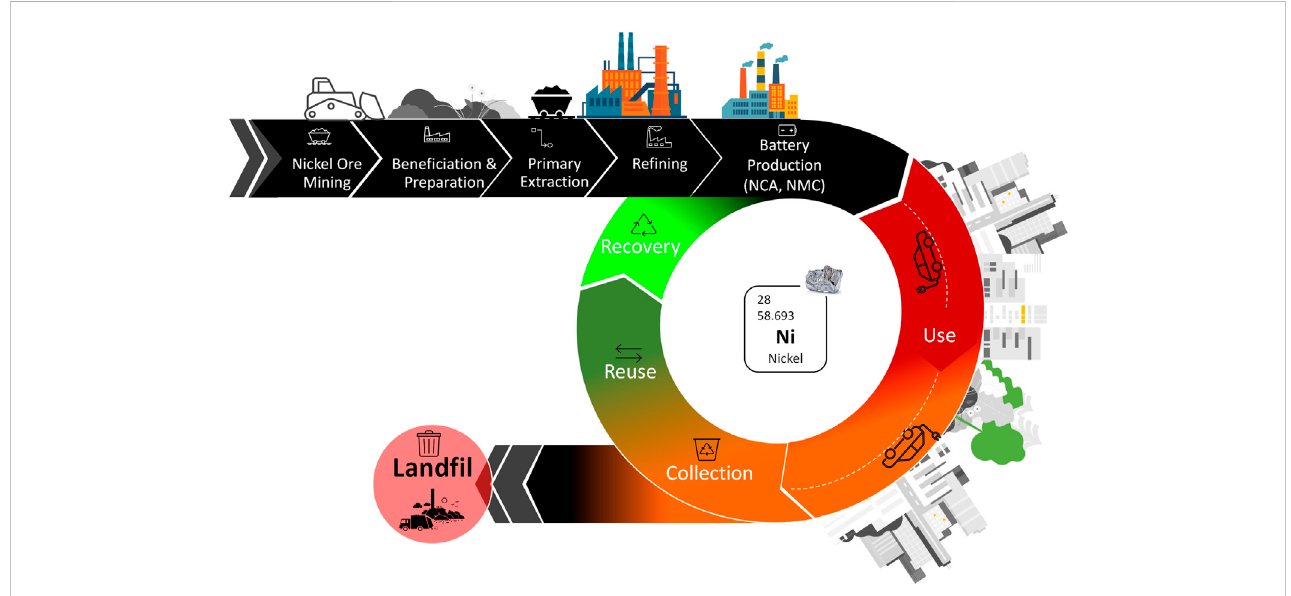
FIGURE 1 Conceptual framework of the proposed model of nickel supply